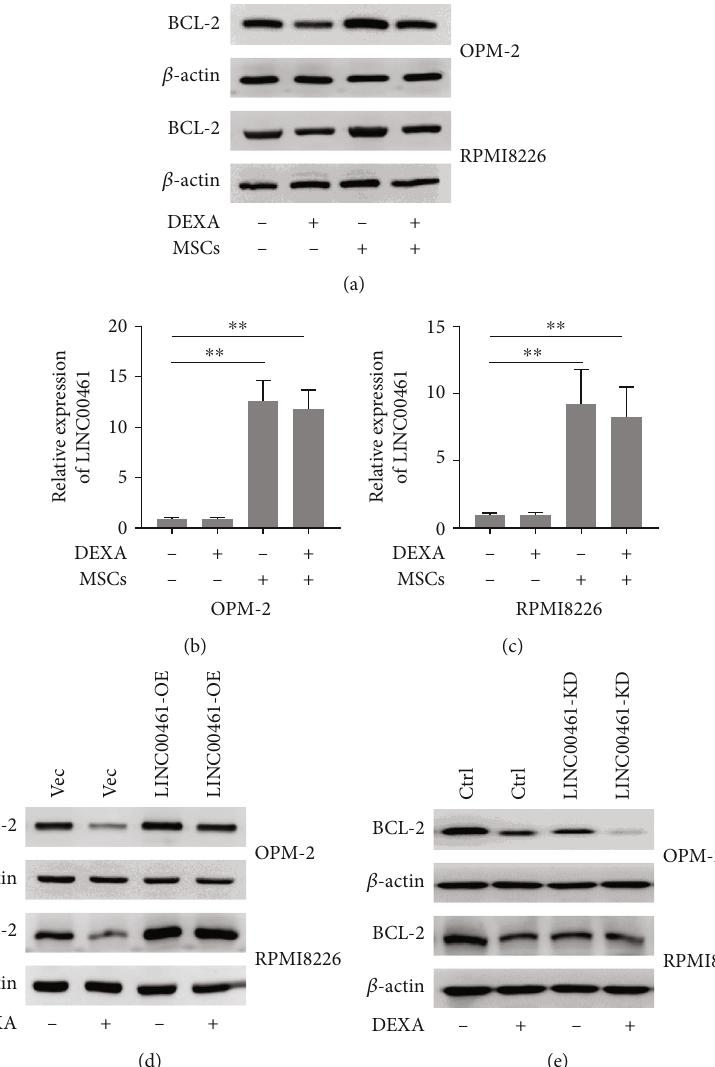
Figure 3: The overexpression of LINC00461 promoted the protein expressions of BCL-2. (a) The OPM-2 or RPMI8226 cells were cocultured with or without MSCs in a 6-well transwell microplate with or without dexamethasone (10 μ M). After 48 hours, the protein expressions of BCL-2 were determined in the OPM-2 or RPMI8226 cells by using qRT-PCR and western blotting analysis, respectively. In addition, (b, c) the relative expression of LINC00461 in OPM-2 and RPMI8226 cells was determined by using qRT-PCR. (d) The protein expressions of BCL-2 were determined by using western blot analysis in the normal OPM-2 and RPMI8226 cells and LINC00461 overexpressing cell lines (LINC00461-OE). β -Actin was used as an internal control. (e) The protein expressions of BCL-2 were determined by western blot analysis in the normal OPM-2 and RPMI8226 cells and LINC00461 knockdown cells (LINC00461-KD). β - Actin was used as an internal control. One-way ANOVA. ∗∗ p < 0 : 01